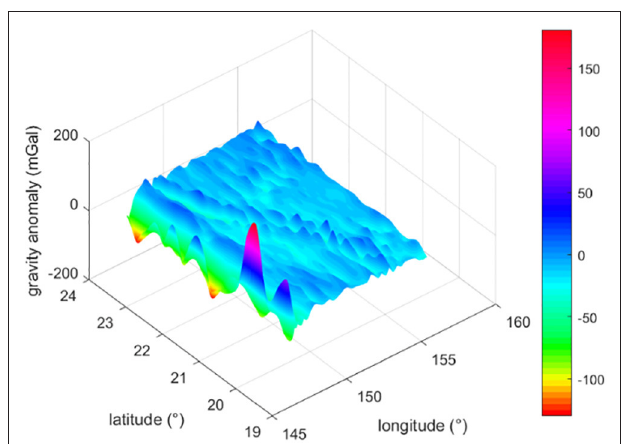
TABLE 2 | Parameters of gravity anomaly base map.